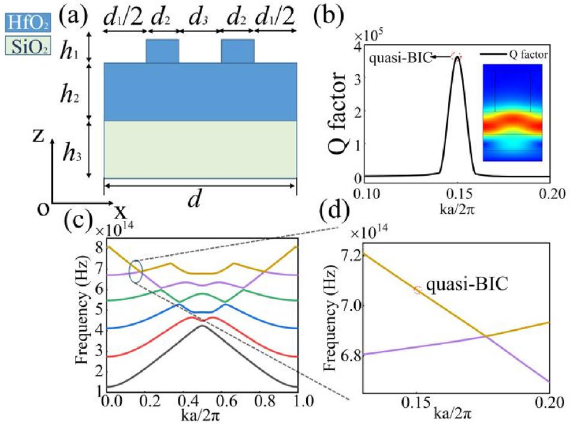
Figure 4. ( a ) A schematic of the grating in the x-o-z -plane. ( b ) A high Q factor of the optical bound states in the continuum (BIC) can be seen. The inset shows the electric field predominantly existing within the waveguide layer. ( c ) The energy bands of the grating are calculated via a mode analysis, where an optical singularity close to the point of the BIC can be seen. ( d ) The details of the BIC can be seen in the zoomed in region of the energy band diagram.